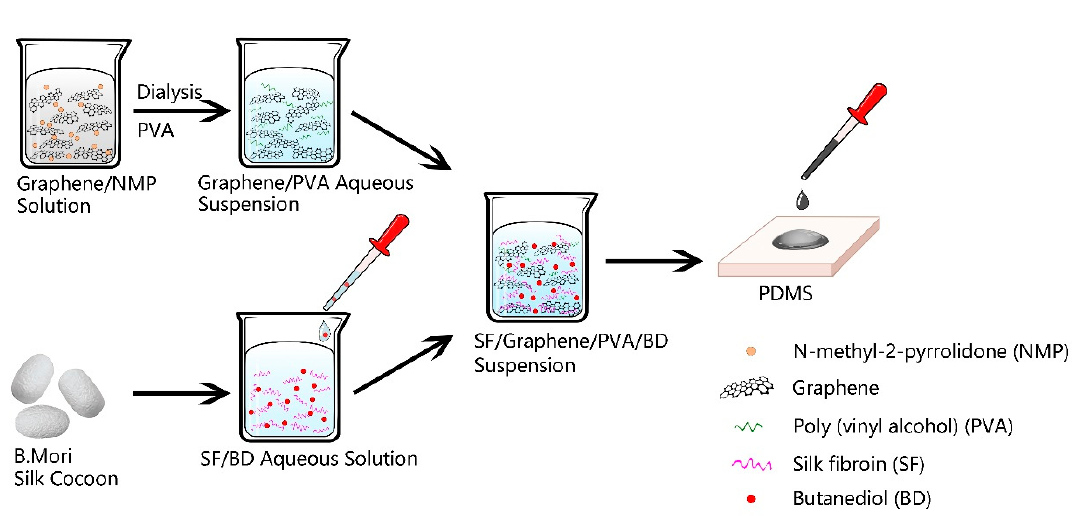
Figure 1. Flow chart for preparation of SF/Graphene film.